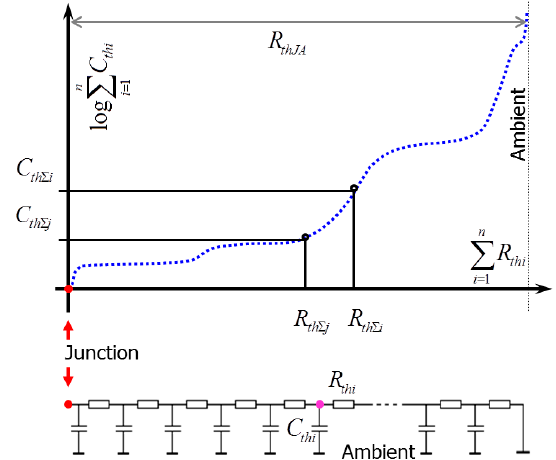
Figure 10. Structure function: the graphic representation of the thermal RC equivalent of the system (from [11]).